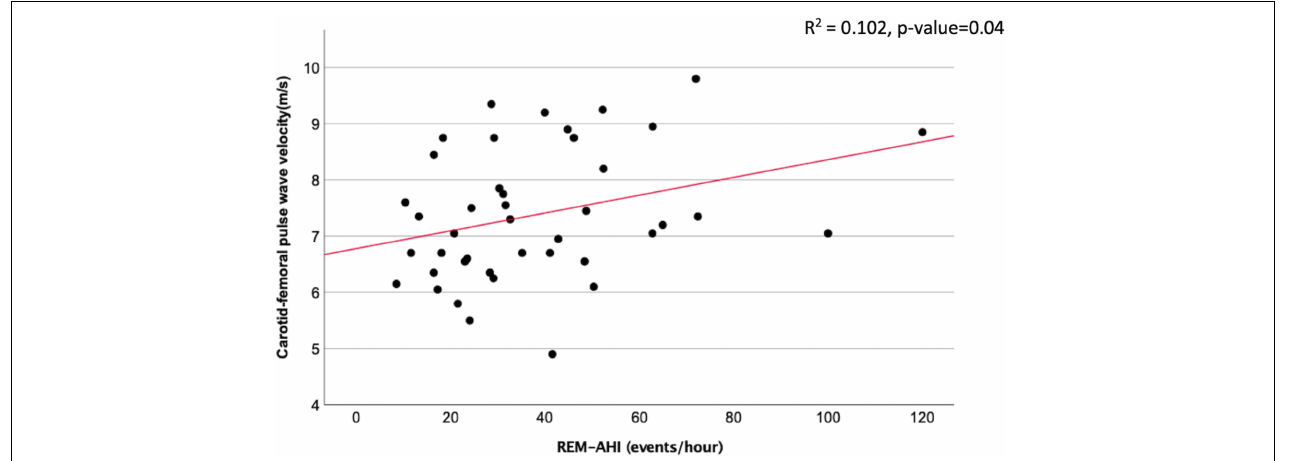
FIGURE 3 | Linear regression model demonstrated association between carotid femoral pulse wave velocity and REM-apnea hypopnea index (REM-AHI).